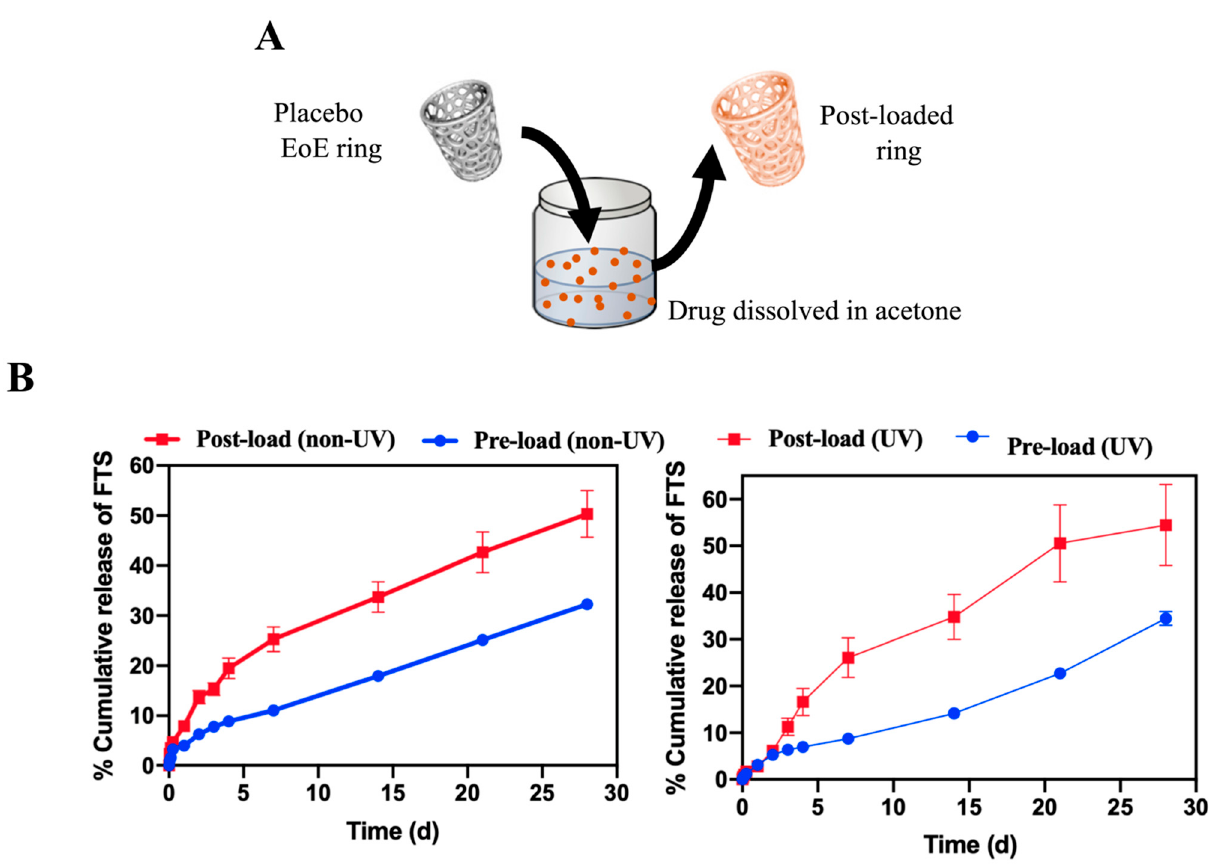
Figure 3. Effect of drug incorporation process onto drug release kinetics of rings printed with the PCL 700 -DMA resin formulation. ( A ) A pictorial representation of post-loading of FTS into 3D printed placebo ring. ( B ) In vitro release kinetics of FTS from pre-loaded (non-UV- and UV-cured rings) and post-loaded (non-UV- and UV-cured rings) printed using the PCL 700 -DMA resin formulation. Rings were incubated in PBS at 37 °C for 30 days and sample aliquots (1 mL) were collected and analyzed by HPLC analysis. All error bars represent standard deviation for n = 3. Table 6. Total amount of FTS in rings normalized to the weights of rings (n = 3), release rate of FTS at zero order kinetics ( μ g/day).